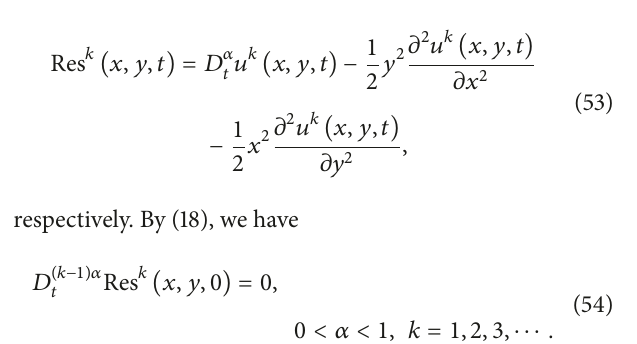
Figure 4: The approximate solutions 𝑢 19 , 𝑢 20 , 𝑢 21 , and 𝑢 22 of (36).